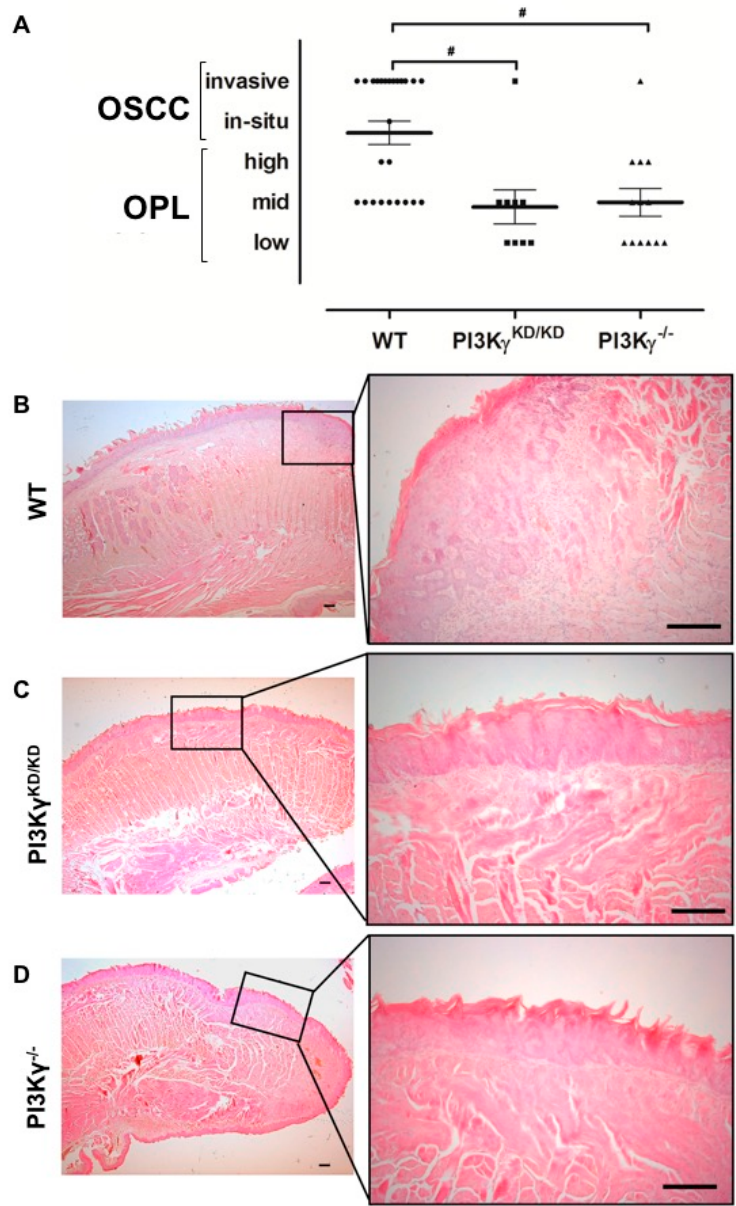
Figure 3. ( A ) Histological analysis: global overview of WT, PI3K γ KD/KD and PI3K γ –/– mice lesions at sacrifice. ( B – D ) Representative H&E staining of tongue sections in ( B ) WT, ( C ) PI3K γ KD/KD and ( D ) PI3K γ –/– mice at the end of 4NQO treatment (22 weeks). Values represent mean ± SEM. PI3K γ KD/KD /PI3K γ –/– vs. WT: # p < 0.01. Scale bars, 100 µm. 3.4. Immunohistochemical Analysis of Prognostic-Related Biomarker of Oral Cancerogenesis Table 2 depicts the results of IHC staining of WT, PI3K γ KD/KD and PI3K γ –/– lesions. EGFR expression is decreased in mutated mice, both in preneoplastic and OSCC. Neu and Ki67 expression is also higher in control mice masses, despite being more evident in OSCC